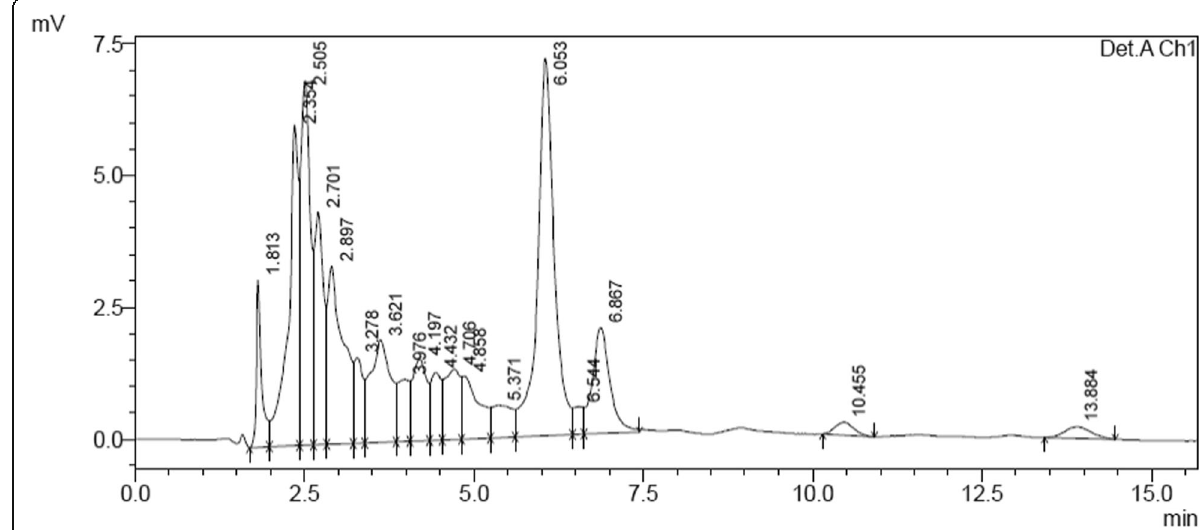
Fig. 4 Chromatogram of LLOQ sample